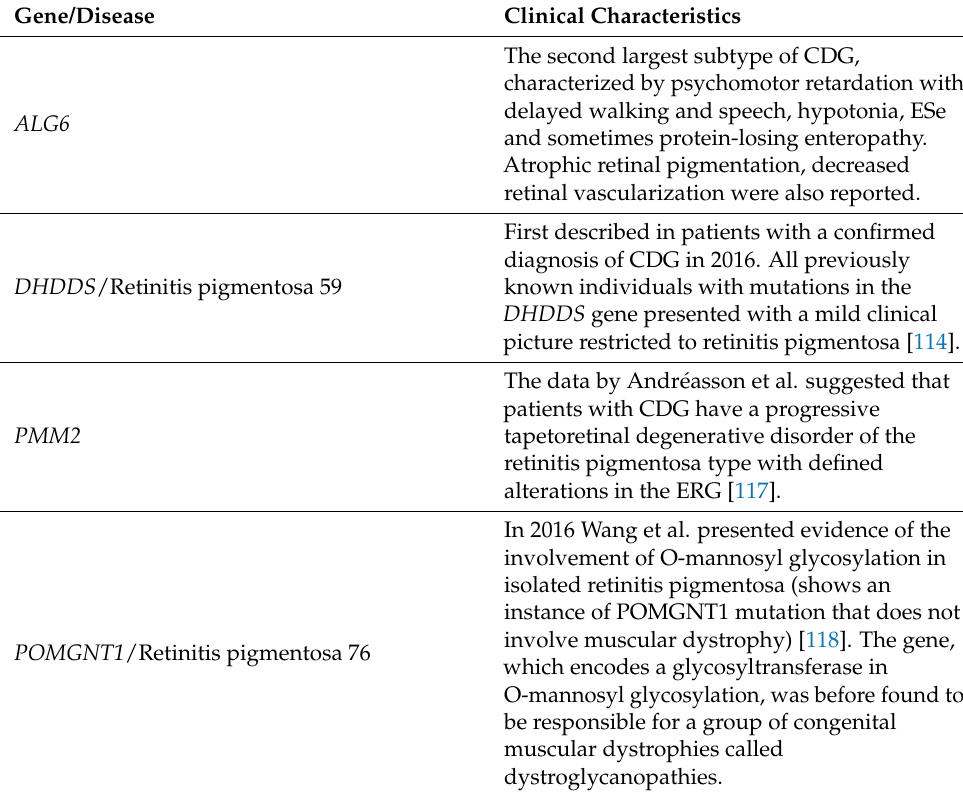
Table 6. Retinitis pigmentosa as a feature of genes, causing CDG